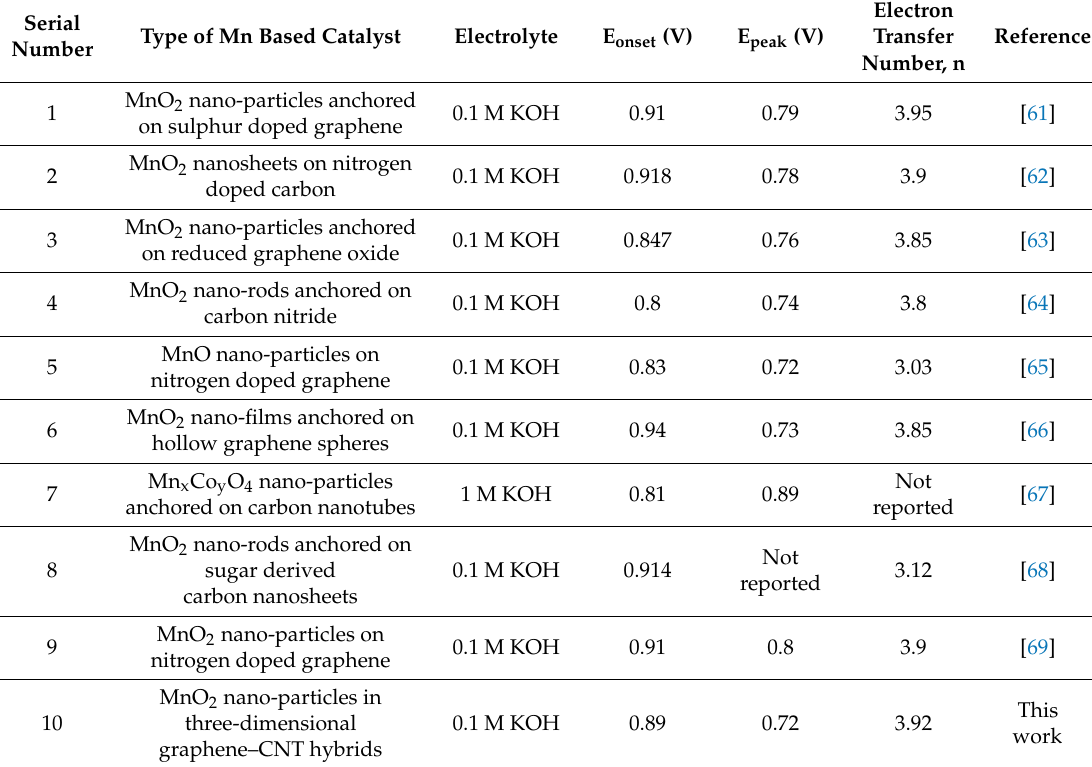
Table 1. Comparison of oxygen reduction reaction (ORR) performance our electrode with other MnO 2 anchored / hybridized / embedded in other carbon based